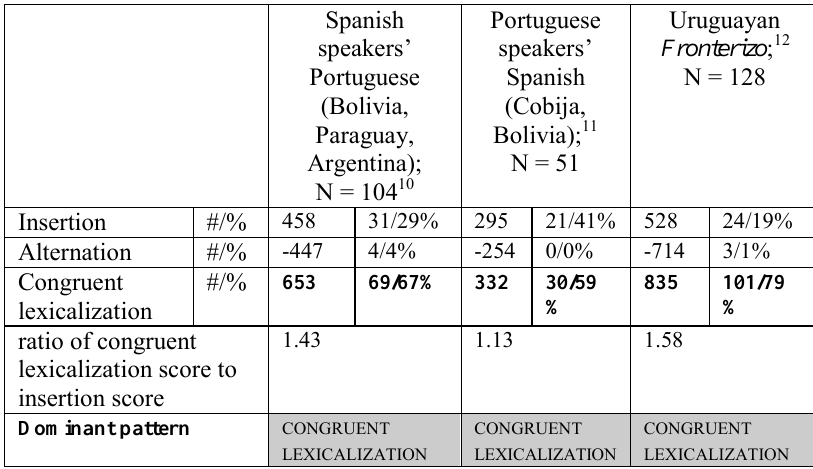
Table 4: Composite scores for language